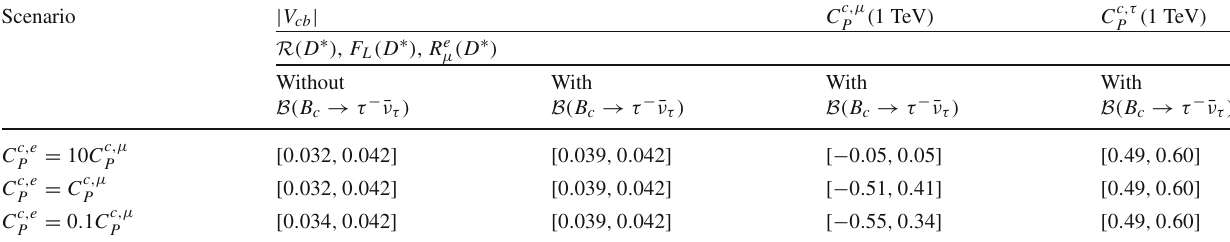
,μ and C c . For completeness we present the effect of including P P